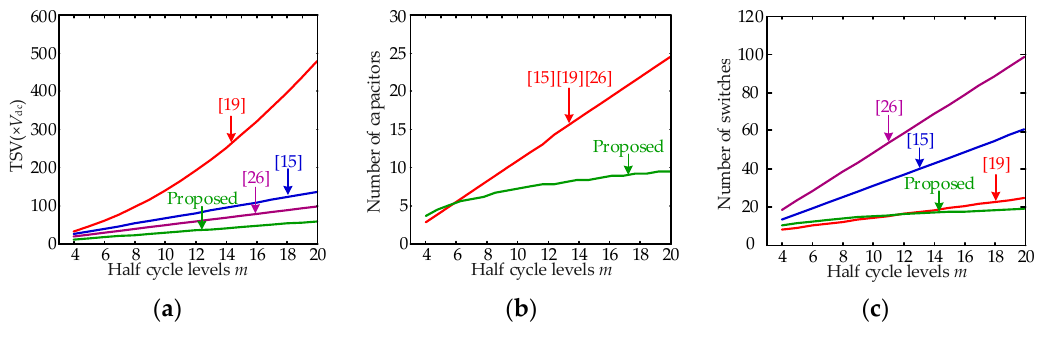
Figure 12. Comparison of expansions. ( a ) Total standing voltage (TSV). ( b ) Number of capacitors. ( c ) Number of switches.